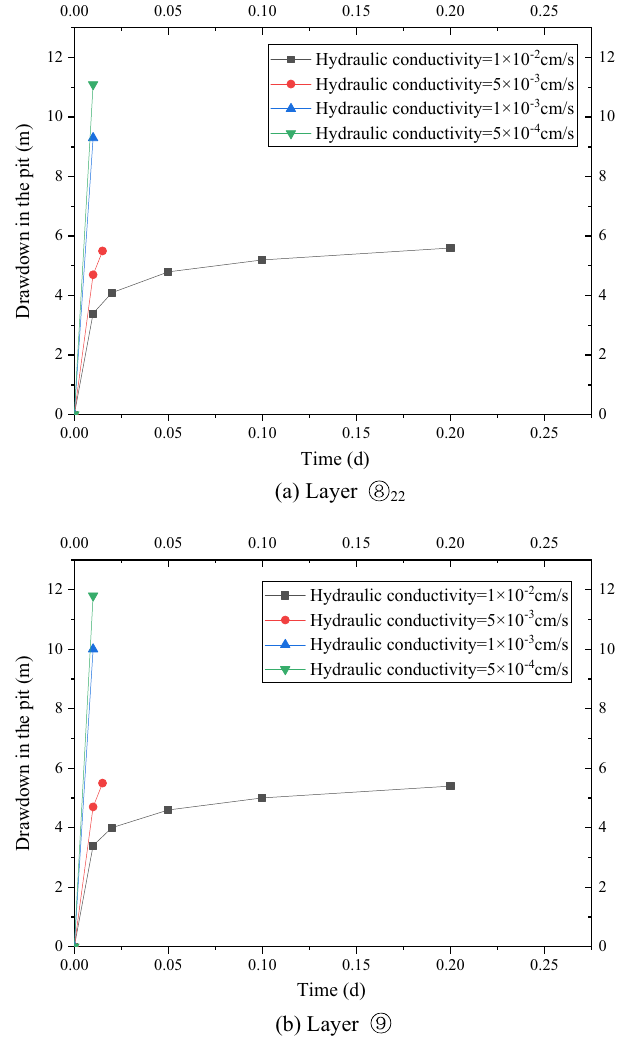
Figure 13. Drawdown–time curve in the pit with different hydraulic